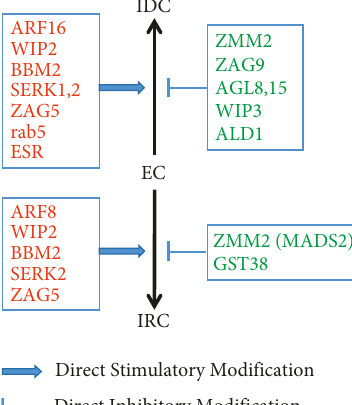
Figure 8: Expression of DEGs from EC to IDC and EC to IRC. Red means upregulated; the green means downregulated. ARF16, auxin response factors 16; wip2, wound inducible protein 2; BBM2, baby boom 2; ERK1, somatic embryogenesis receptor-like kinase 1; SERK2, somatic embryogenesis receptor-like kinase 2; ZAG5, zea agamous5; Rab5, responsive to abscisic acid 5; ESR, embryo sur- rounding region-related; ZMM2, Zea mays MADS2; ZAG9, zea agamous9;AGL8,Agamous-like8;AGL15,Agamous-like15;WIP3, wound-inducible protein 3; ALD1, aldolase 1; GST38, glutathione- S-transferase38; MADS2, MADS transcription factor